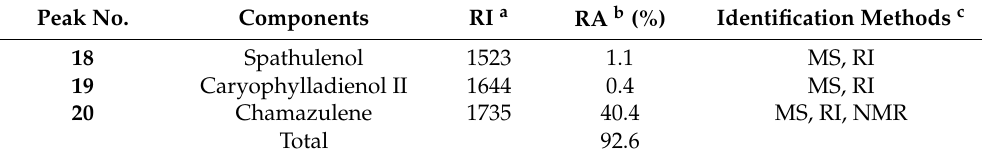
Figure 2. The other three monoterpenoids from the essential oil of A. lavandulaefolia .